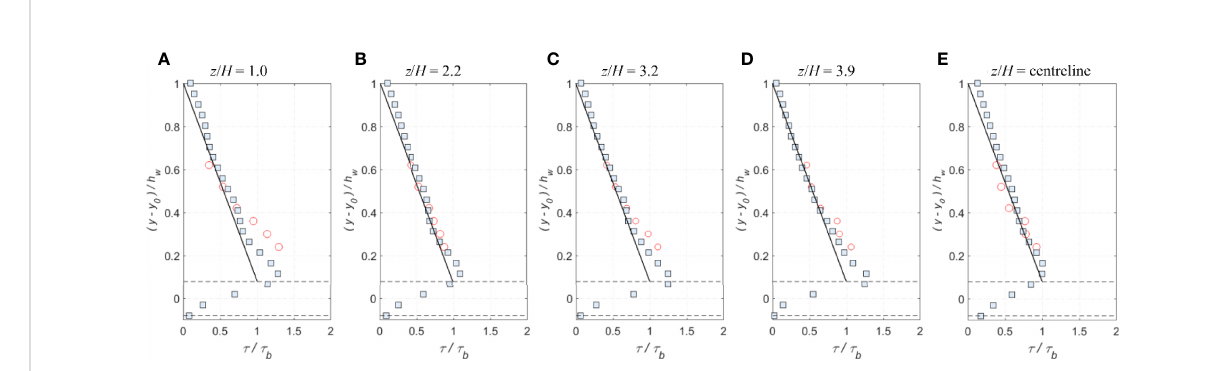
FIGURE 12 (A – E) Comparisons of the lateral pro fi les of time-averaged shear stress between experimental, analytical and SPH results for shallow fl ow condition 2 (circles: exp data; squares: SPH; solid black lines: analytical; and dash lines: roughness top and